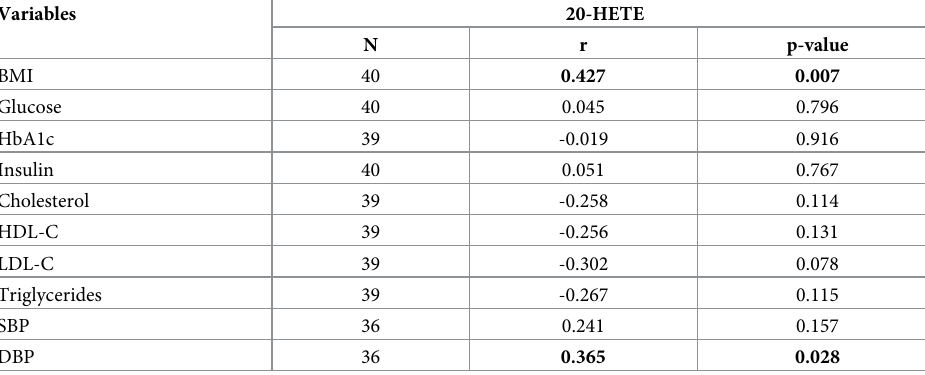
was calculated using Spearman’s r correlation test. P < 0.05 is considered statistically